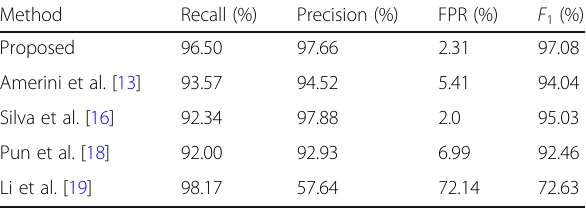
Table 2 Detected results for CMH1 dataset under simple copies